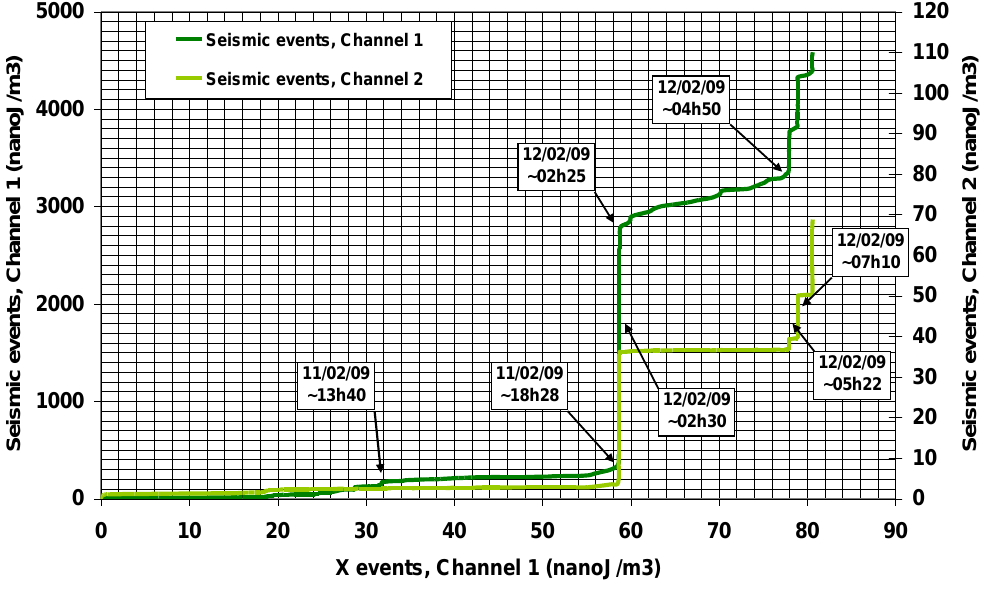
Fig. 7. Evolution of the AE energy during the controlled collapse (parametric representation of “seismic” energy from channels 1 and 2 versus “X” energy from channel 1)